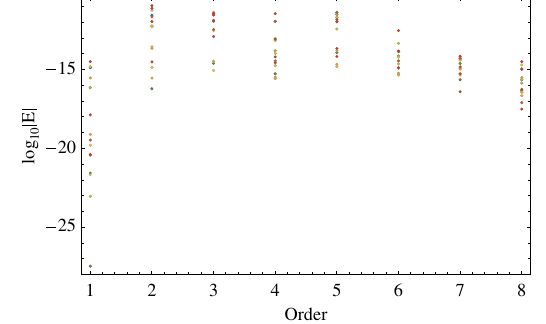
FIG. 8. Symplectic error, E , absolute matrix terms for initial values ð x; y; z Þ ¼ 0 . 01 and ð p x ; p y ; δ Þ ¼ 0 . 0001 from eighth order in Taylor series map. Voltage normalized to 4.155